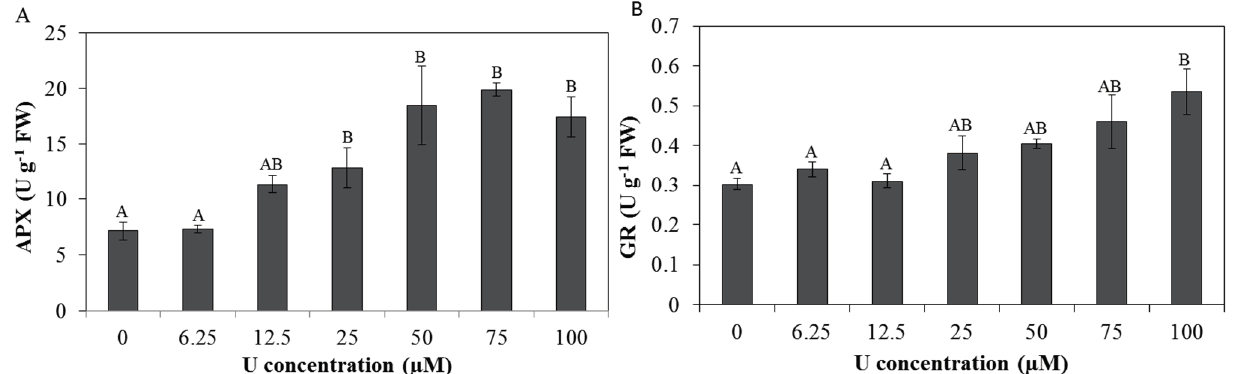
Figure 4. Enzyme capacities (units (U)·g − 1 FW) of ascorbate peroxidase ( A , APX) and glutathione reductase ( B , GR) in Arabidopsis thaliana roots exposed to different U concentrations for three days at pH 7.5. Values represent the mean ± S.E. of at least four biological replicates. Data points with different letters are significantly different ( p <